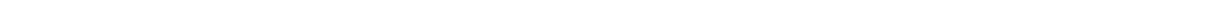
Fig. 2 NPC characterization and ZIKV BR infection in DZ-D cells (see also Supplementary Fig. 1). a , b NPCs were stained with isotype IgG APC-A and isotype IgG FITC-A ( a ) and Nestin APC-A and Musashi-1 FITC-A ( b ) and were analyzed by fl ow cytometry to con fi rm (or show) population homogeneity for neural progenitor markers. c Nestin staining by immuno fl uorescence. Scale bar (SB), 20 μ m d Representative phase-contrast micrograph of infected NPCs (#10608 twins). SB, 100 μ m. e Analysis of cell number of Mock-infected NPCs from non-affected and CZS-affected twins ( n = 3 technical replicates; mean ± SEM). f , g MOI 0.01 and 0.1 infected NPCs from non-affected (#10608-4, #10763-4, and #10788-4) ( f ) and CZS-affected (#10608-1, #10763-1, and #10788-1) ( g ) twins in monolayer cultures at 24, 48, 72, and 96 hpi ( n = 3 technical replicates; mean ± SEM; * p < 0.05, ** p < 0.01; two-way ANOVA with Bonferroni post hoc analysis). h Representative images of neurospheres infected with ZIKV BR (#10608 twins, n = 2 technical replicates). SB, 400 μ m. i , j Normalized diameter of neurospheres at 24 and 96 hpi with MOI 0.01 ( i ) or MOI 0.1 ( j ); #10608, #10763 and #10788 twins; n ≅ 15 technical replicates; mean ± SEM; * p < 0.05, ** p < 0.01 Student ’ s t